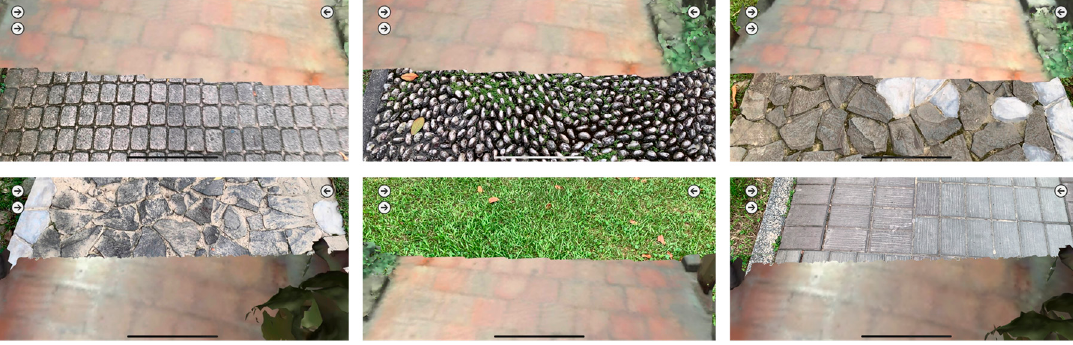
Figure 13. The combination of real paving and 3D models.